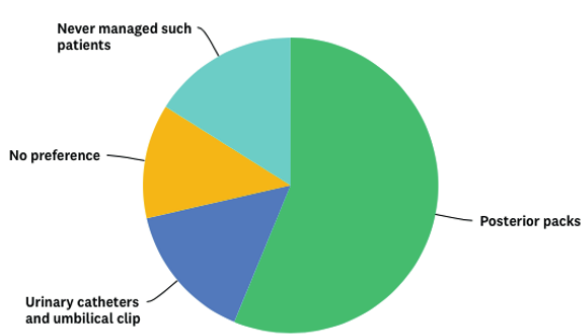
Figure 8. ‘Do you have a preference in the management of posterior epistaxis?’